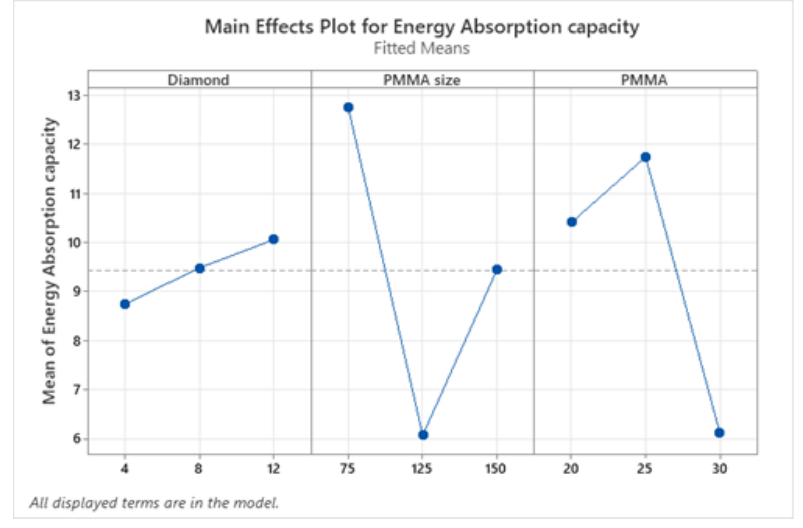
Figure 7. Mean response curve of energy absorption capacity.